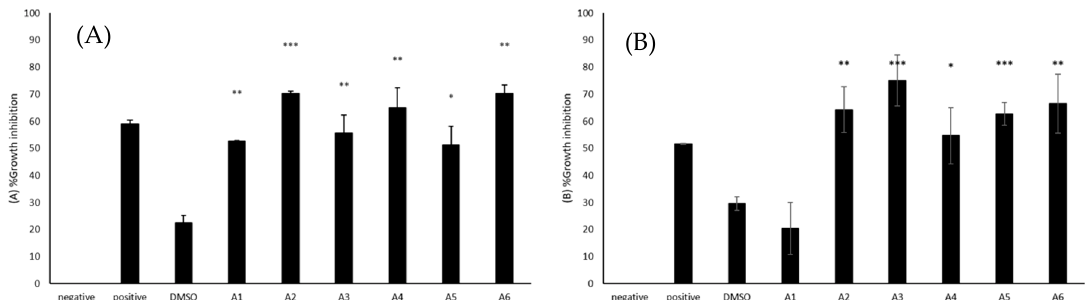
Figure 2. ( A ) The amoebistatic activities of azoles were determined. The results revealed that azoles caused a reduction in the growth of B. mandrillaris cells. ( B ) The results revealed that azoles caused a reduction in the growth of N. fowleri cells. The results are representative of at least three independent experiments performed in duplicates. The data are presented as the mean ± standard error (*: p < 0.05, **: p < 0.01 and ***: p < 0.001 using 2 sample t test; two tailed distribution).